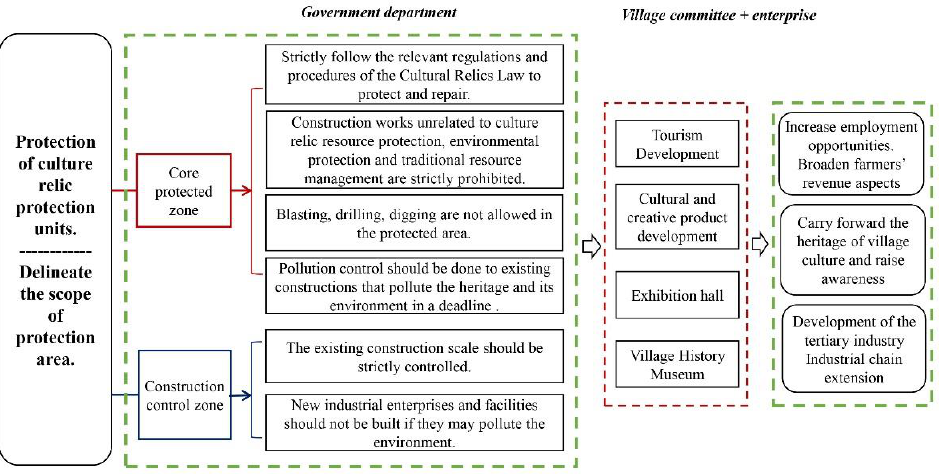
Figure 9. Schematic diagram of protecting cultural relic protection units.